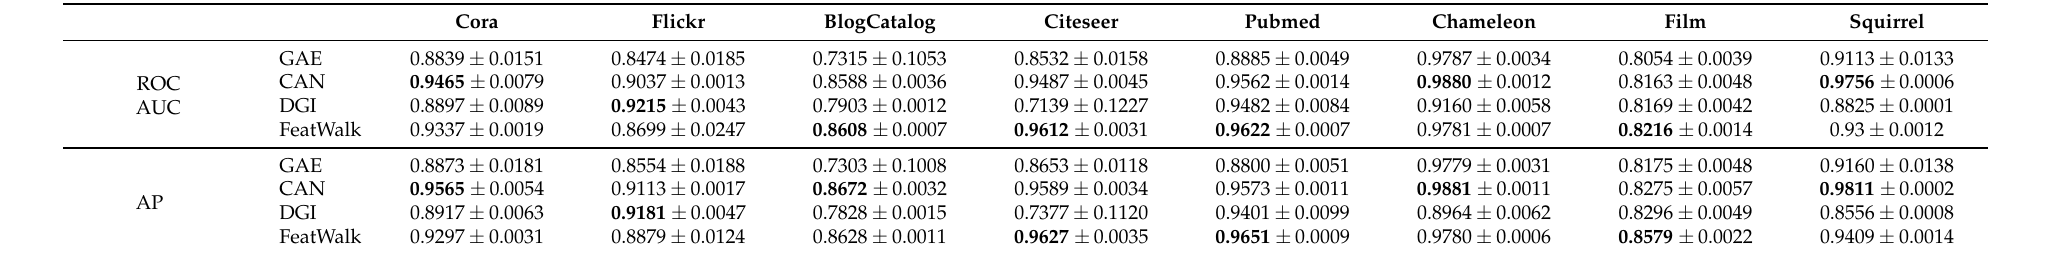
Table 7. Results in Task 2, i.e., link prediction fine-tuned in the first run, on attributed networks, by using random search algorithm to tune hyperparameters. Best results are shown in bold.